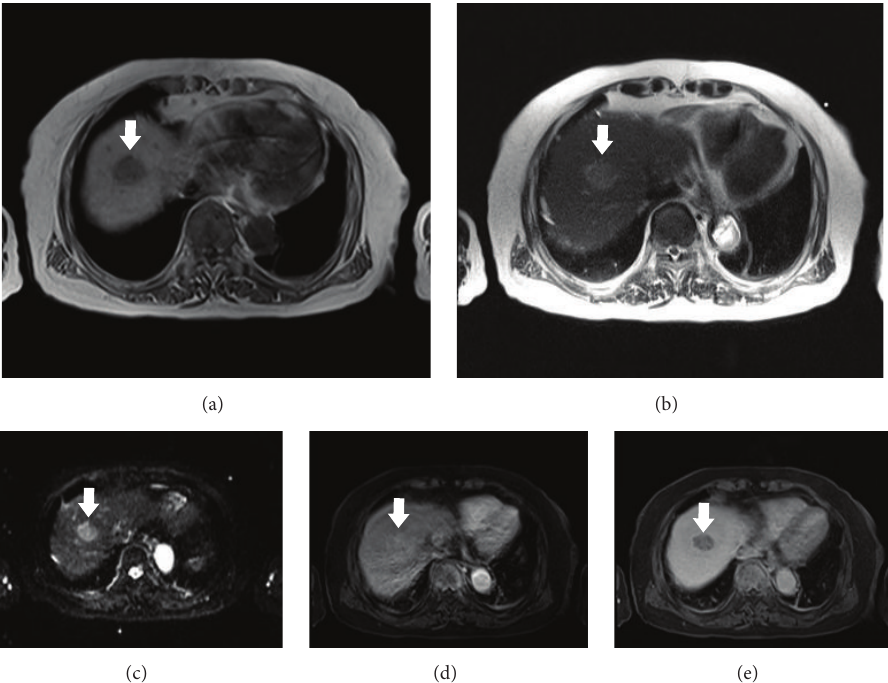
Figure 2: (a) Low signal intensity on T1. (b) High signal intensity on T2. (c) Diffusion restriction positive. (d) Arterial enhancement. (e) Delayed washout (5min).